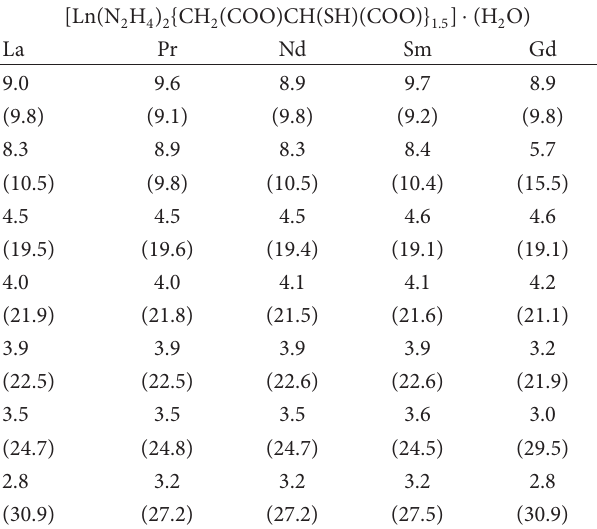
T 5: X-ray diffraction of metal complexes (D spacing in Å units and intensity (Cps) in